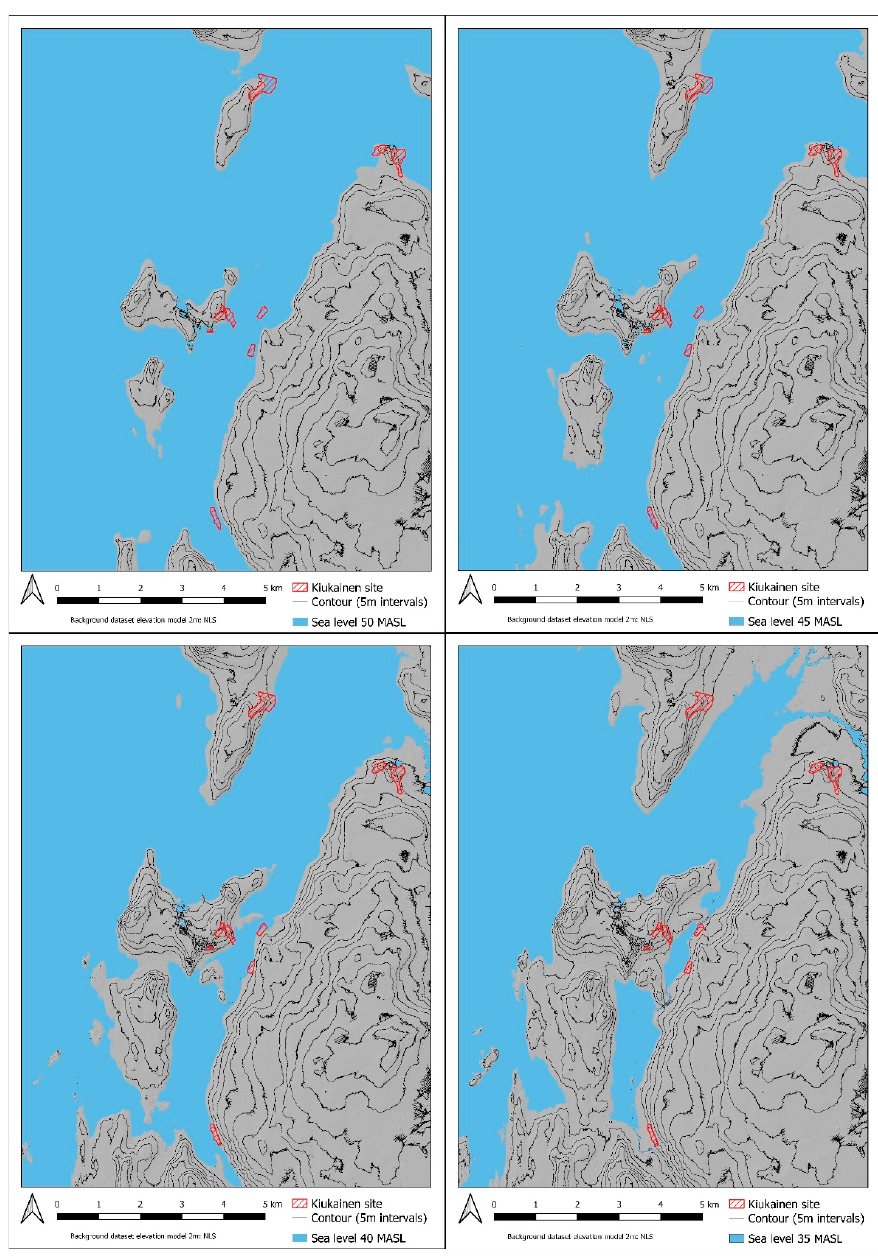
Figure 10. The locations of Kiukainen sites in the Kristiinankaupunki area with different landscape visualizations. The Sea is visualized at 50 MASL (upper left), 45 MASL (upper right), 40 MASL (lower left), and 35 MASL (lower right).